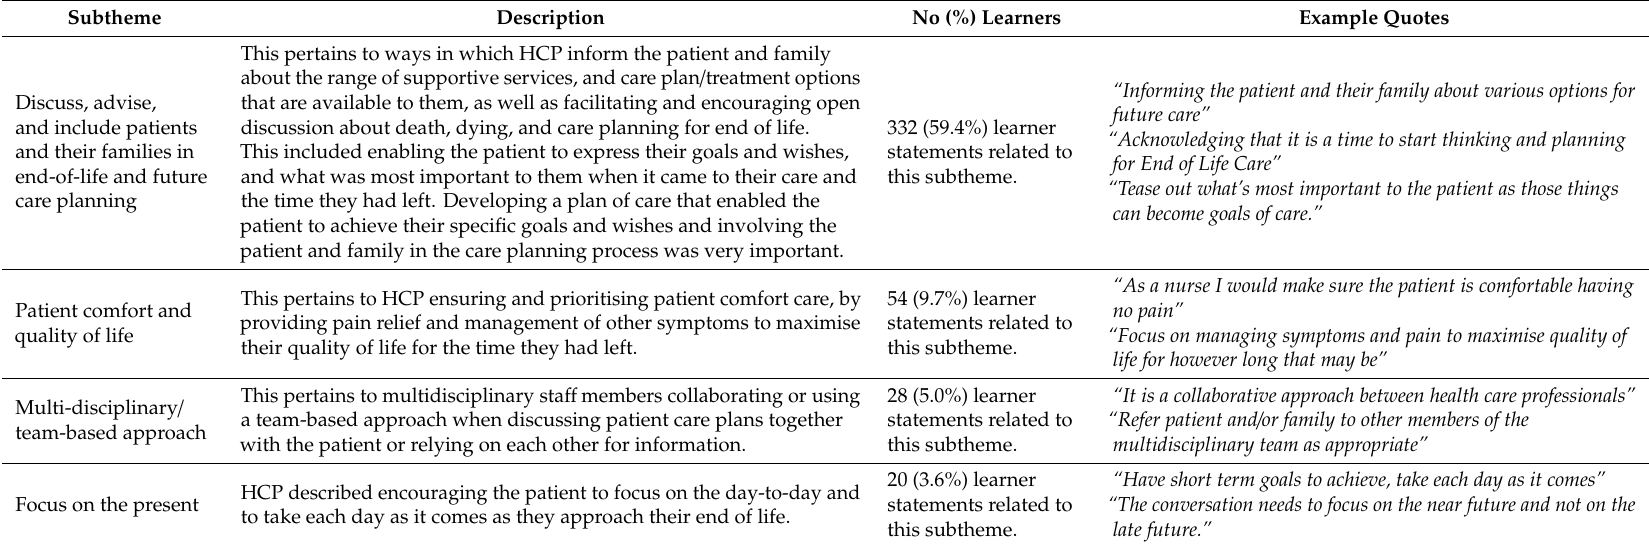
Table 4. Patient-centred care and care planning subtheme